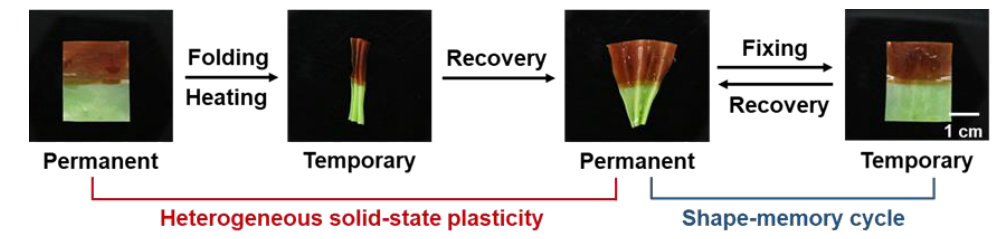
Figure 9. Shape-shifting of a welded film with two different parts.